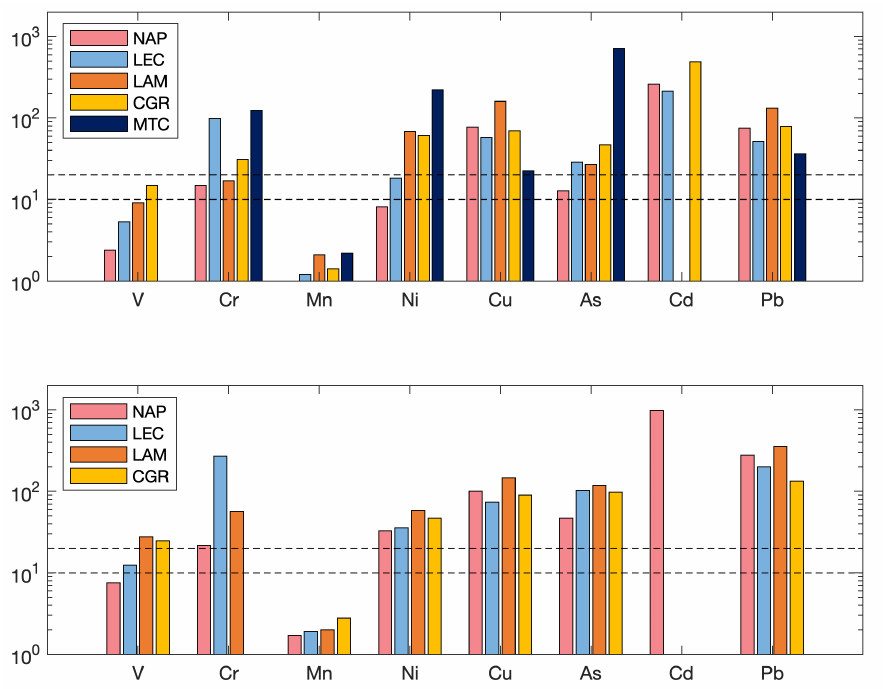
Figure 11. The enrichment factors of the two fractions, PM 10 ( top ) and PM 2.5 ( bottom ), for each site. The two black dashed lines correspond to the two thresholds: EF = 10 and EF =